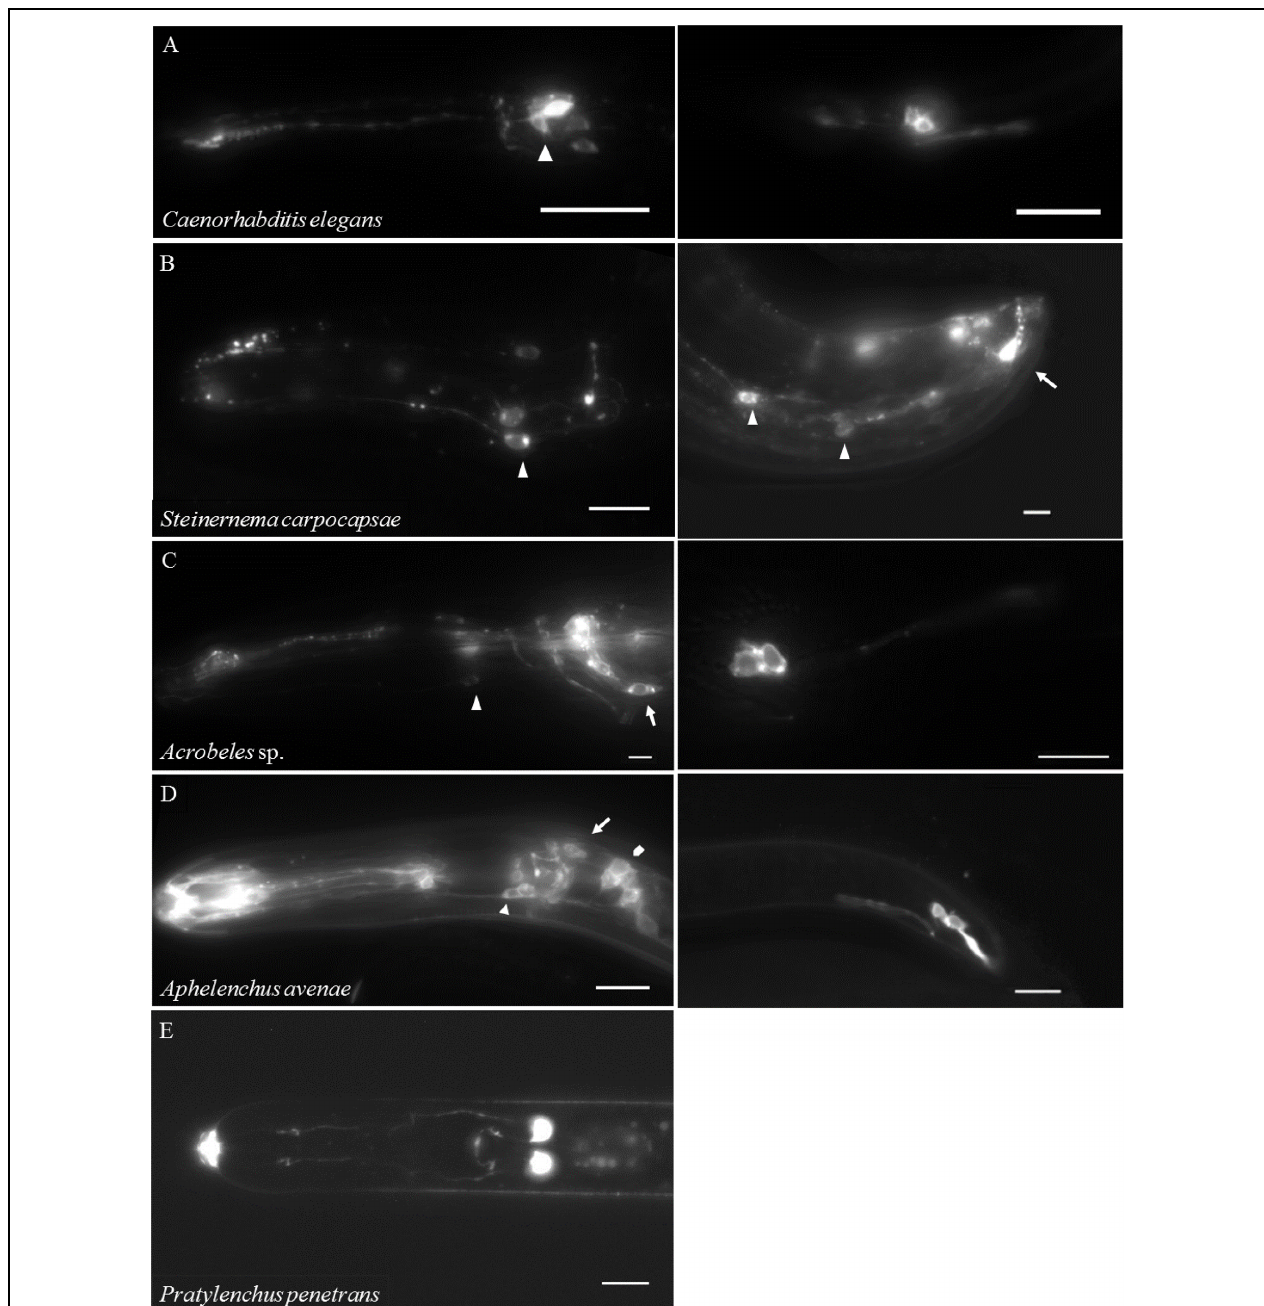
FIGURE 5 | DiI-filling is highly variable among nematodes. Live nematodes were exposed to DiI for 2 h followed by repeated washes in water or buffer and then imaged with fluorescent microscopy. (A) Left Anterior of the Clade 9 nematode Caenorhabditis elegans dauer, arrowhead indicates amphid neurons. (A) Right Posterior of a Caenorhabditis elegans dauer, two pairs of phasmid neurons are shown. (B) Left Anterior of the Clade 10 nematode Steinernema carpocapsae female, arrow indicates inner labial neurons. (B) Right Posterior of a S. carpocapsae male, arrow indicates phasmid neurons and arrowheads indicate unidentified neurons. (C) Left Anterior of the Clade 11 nematode Acrobeles sp. female, arrow indicates amphid neurons and arrowhead indicates inner labial neurons. (C) Right Posterior of an Acrobeles sp. female, two pairs of phasmid neurons are shown. (D) Left Anterior of the Clade 12 nematode Aphelenchus avenae , pentagon indicates amphid neurons, arrow indicates cephalic neurons, and arrow head indicates inner labial neurons. (D) Right Posterior of an Aphelenchus avenae female, two pairs of phasmid neurons are shown. (E) Anterior of the Clade 12 nematode Pratylenchus penetrans female (ventral view), one pair of amphid neurons in the anterior of the nematode is shown. Scale bar = 10 µ m for all